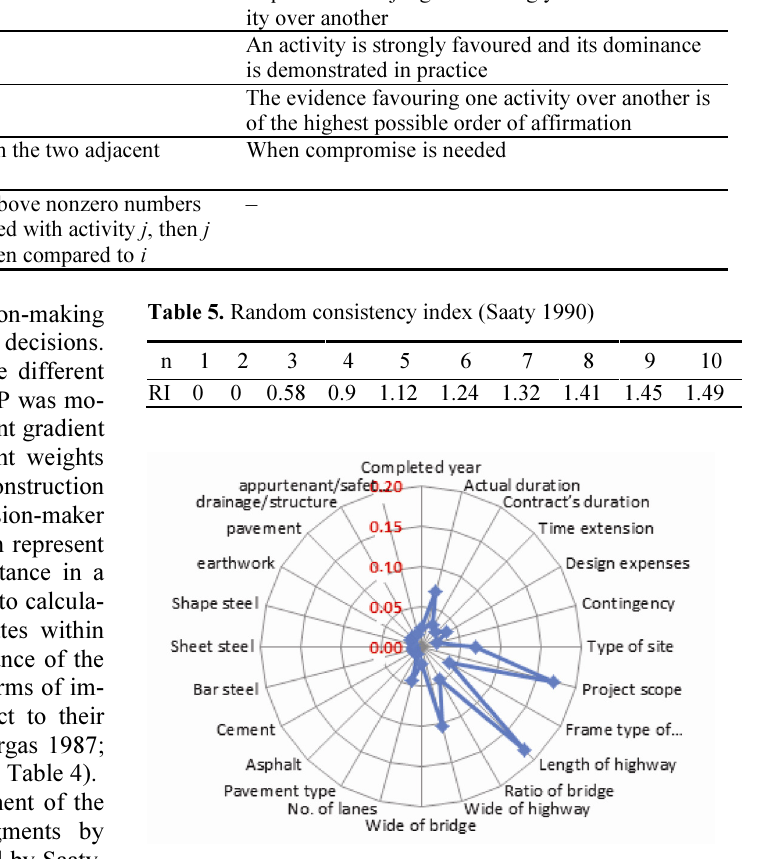
Fig. 3. Weights of CFs obtained by means of AHP